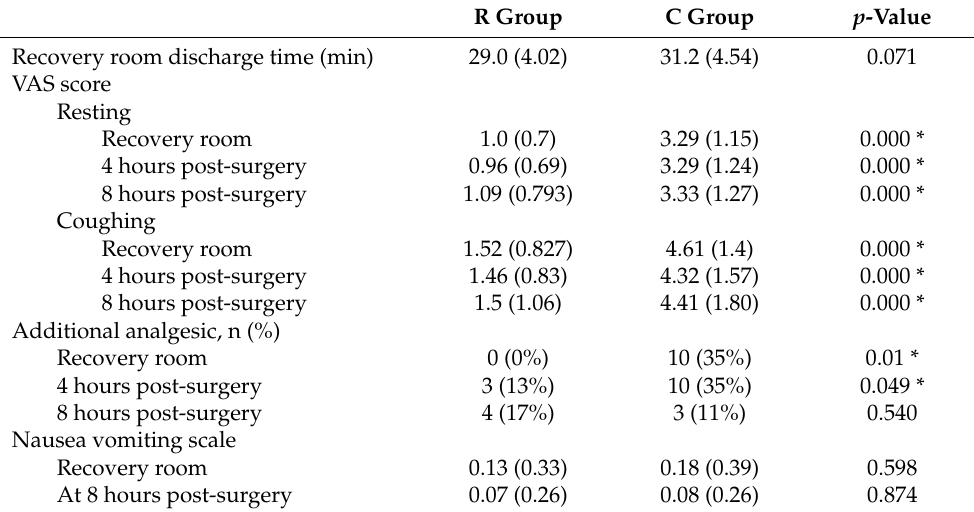
Figure 4. Remifentanil dose distribution between two groups. Gray bars indicate average remifentanil consumption doses of each group. Table 3. Postoperative pain-related